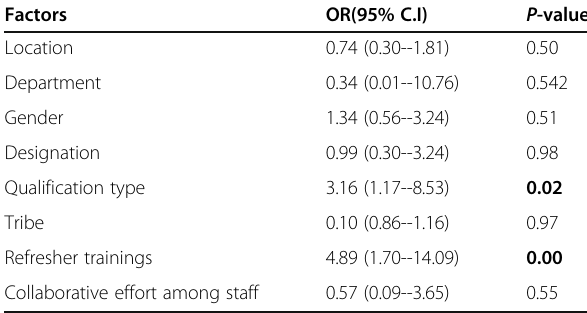
Table 3 Factors influencing level of knowledge about